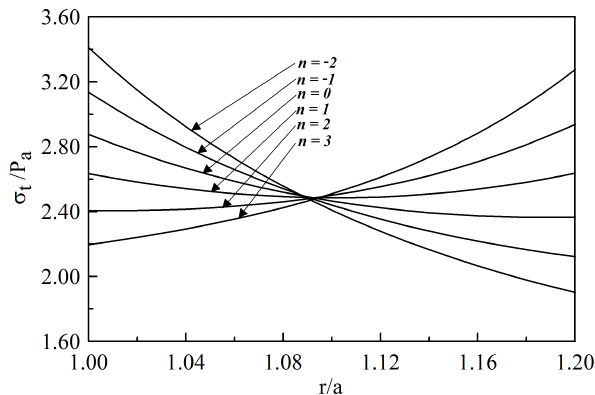
Figure 44: Radially distributed tangential stress